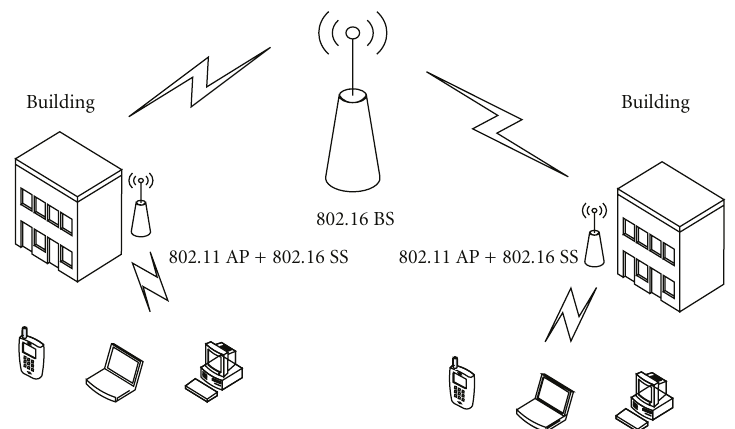
Figure 1: A typical scenario of the collaborative IEEE 802.11 and IEEE 802.16 networks.